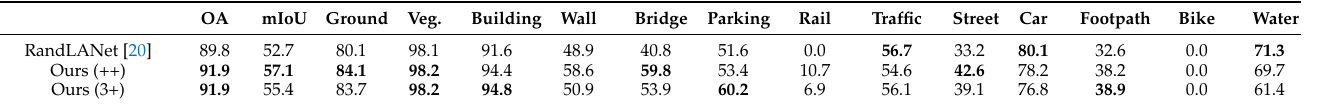
Table 1. Segmentation results evaluated for IoU in each category, mIoU, and OA of SensatUrban dataset. Note: the bold number represents the highest score in each column. The RandLA-Net network results is from this paper [20].